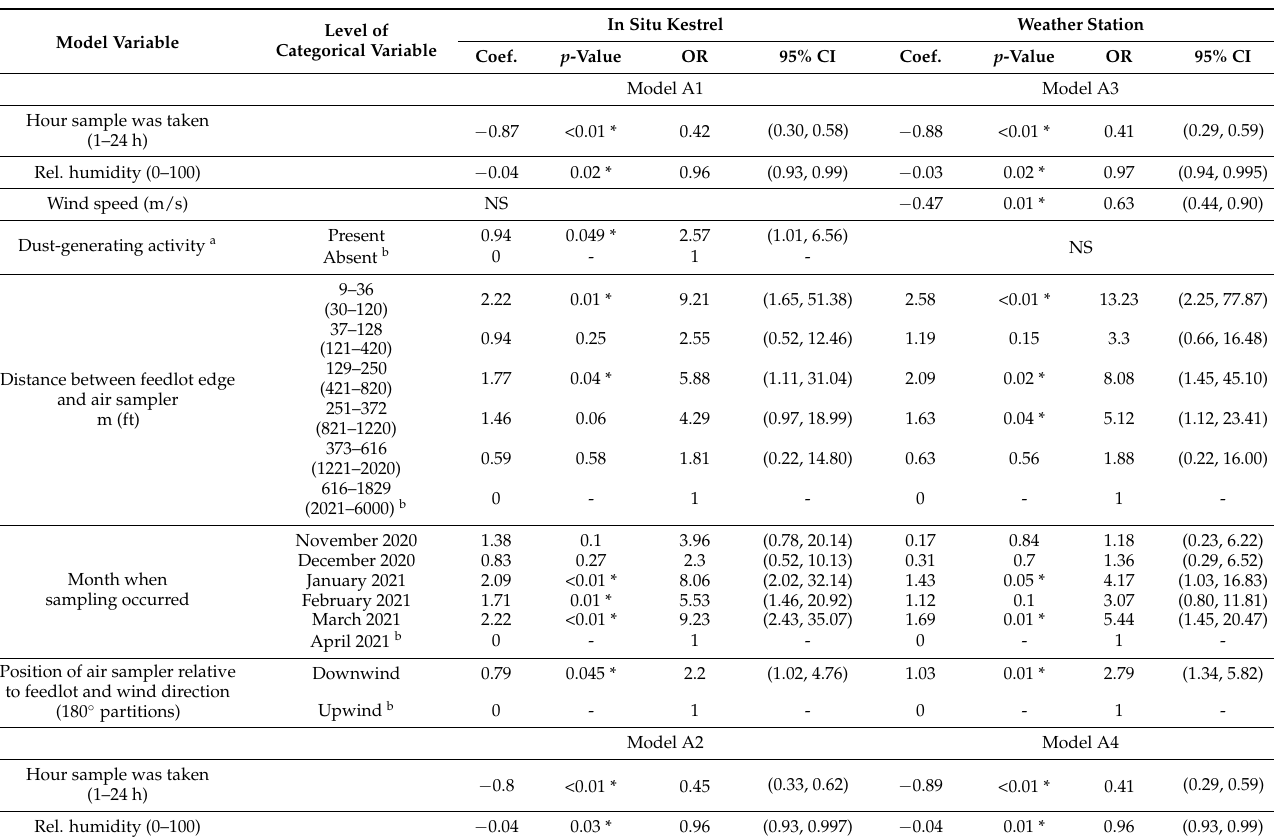
Table 2. Logistic regression model for the association between indicator of airborne E. coli